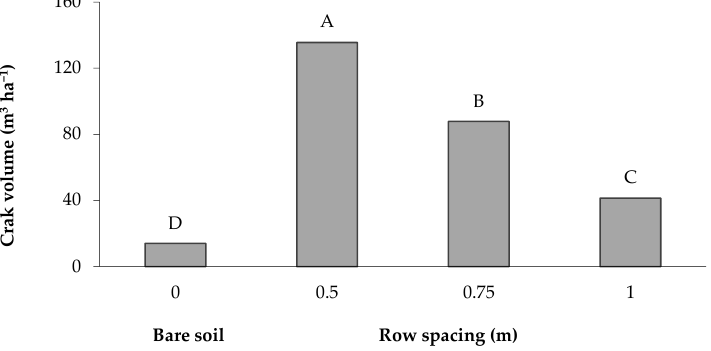
Figure 7. Volume of desiccation cracks in the bare soil and maize-cultivated soil under different row spacings. The bars with the same letter are not significantly different (SNK test at p = 0.01).